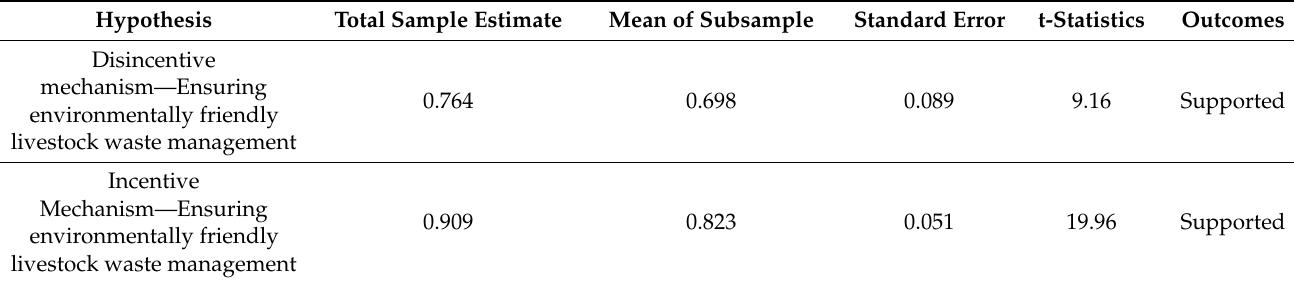
Table 7. Bootstrap results of the model (inner